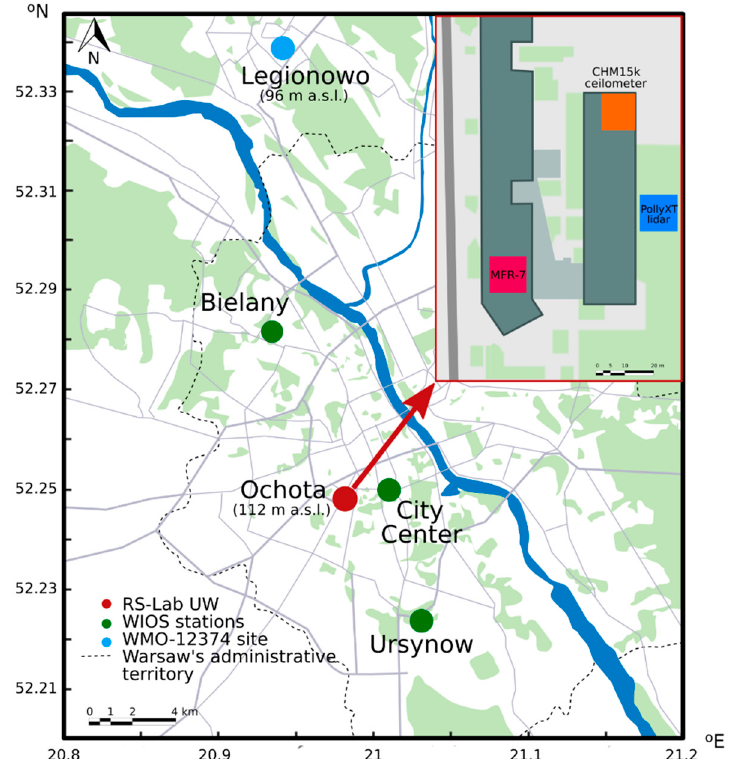
Figure 1. Location of the Remote Sensing Laboratory (RS-Lab) at the Ochota Campus of the University of Warsaw in the city center (in red), the World Meteorological Organization site (WMO-12374) in the small town Legionowo (in blue), and the Chief Inspectorate for Environmental Protection of Poland (WIOS) PM 2.5 and PM 10 monitoring stations (in green). The locations of the PollyXT lidar, the CHM15k ceilometer, and the MFR-7 shadowband radiometer at the RS-Lab at ground-based station and two roof-platforms are indicated ( map provided by Olga Zawadzka-Ma ń ko ) .